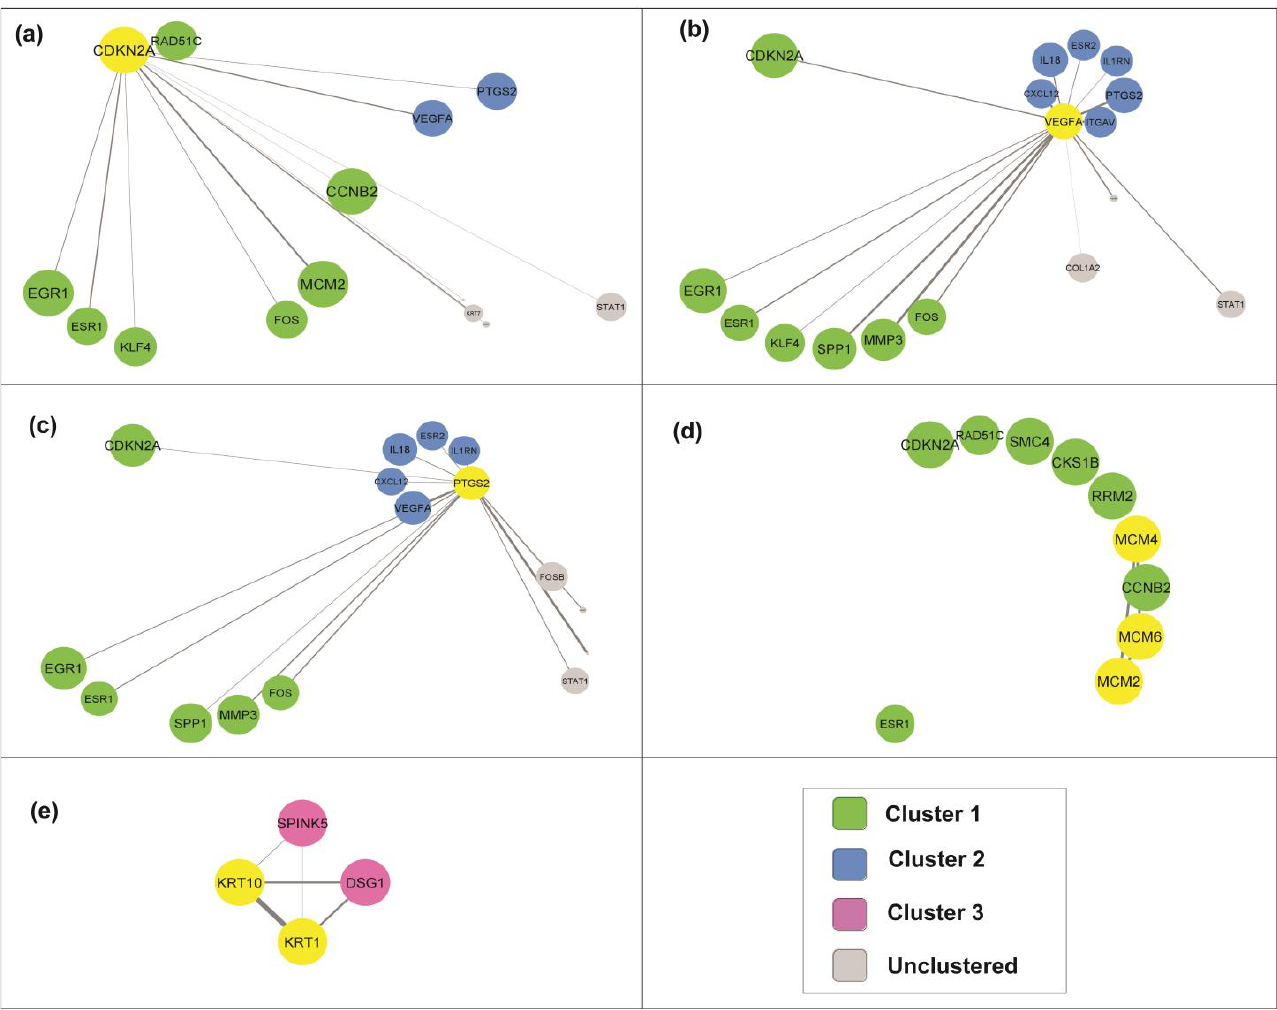
Figure 4. Protein interaction through undirected first neighbor of the candidate genes (highlighted in yellow) from cluster 1: ( a ) CDKN2A , ( b ) VEGFA , ( c ) PTGS2 , ( d ) MCM family, and ( e ) KRT